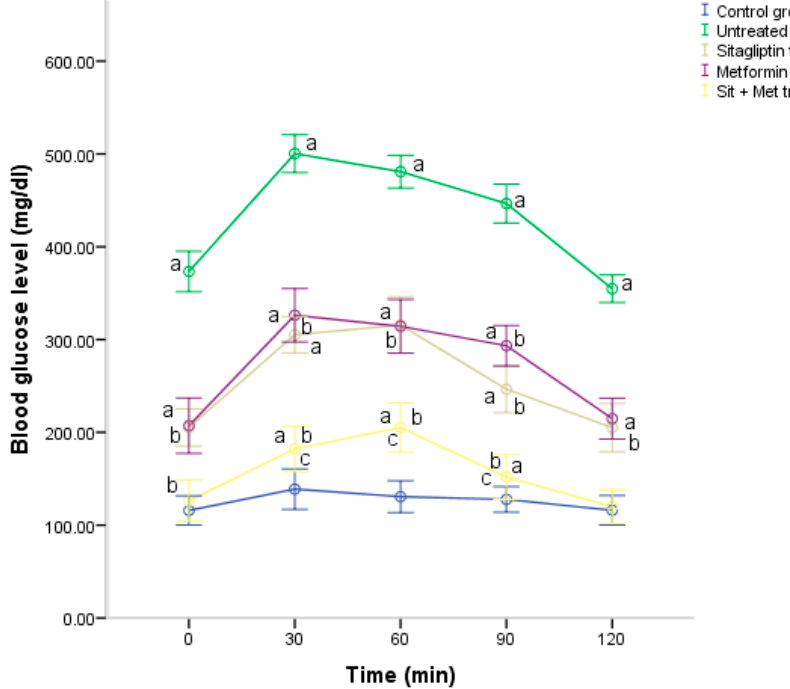
Figure 3. Changes in the blood glucose level (mg/dL) during the conduction of OGTT (oral glucose tolerance test) in the experimental groups at the end of the treatment period. The data were expressed as a mean ± SD (n = 10). a : significantly different, compared to the control group. b : significantly different, compared to the untreated diabetic group. c : significantly different, compared to the sitagliptin and metformin-treated groups, using post hoc ANOVA (LSD), p < 0.05.